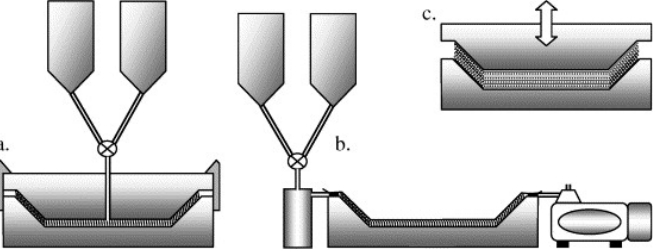
Figure 2. Schematic representation of three reactive processes for manufacturing of thermoplastic composites: ( a ) structural reaction injection molding (SRIM), ( b ) vacuum infusion (VI) and ( c ) resin film infusion (RFI). Reprinted from Reference [54], under open-access license.